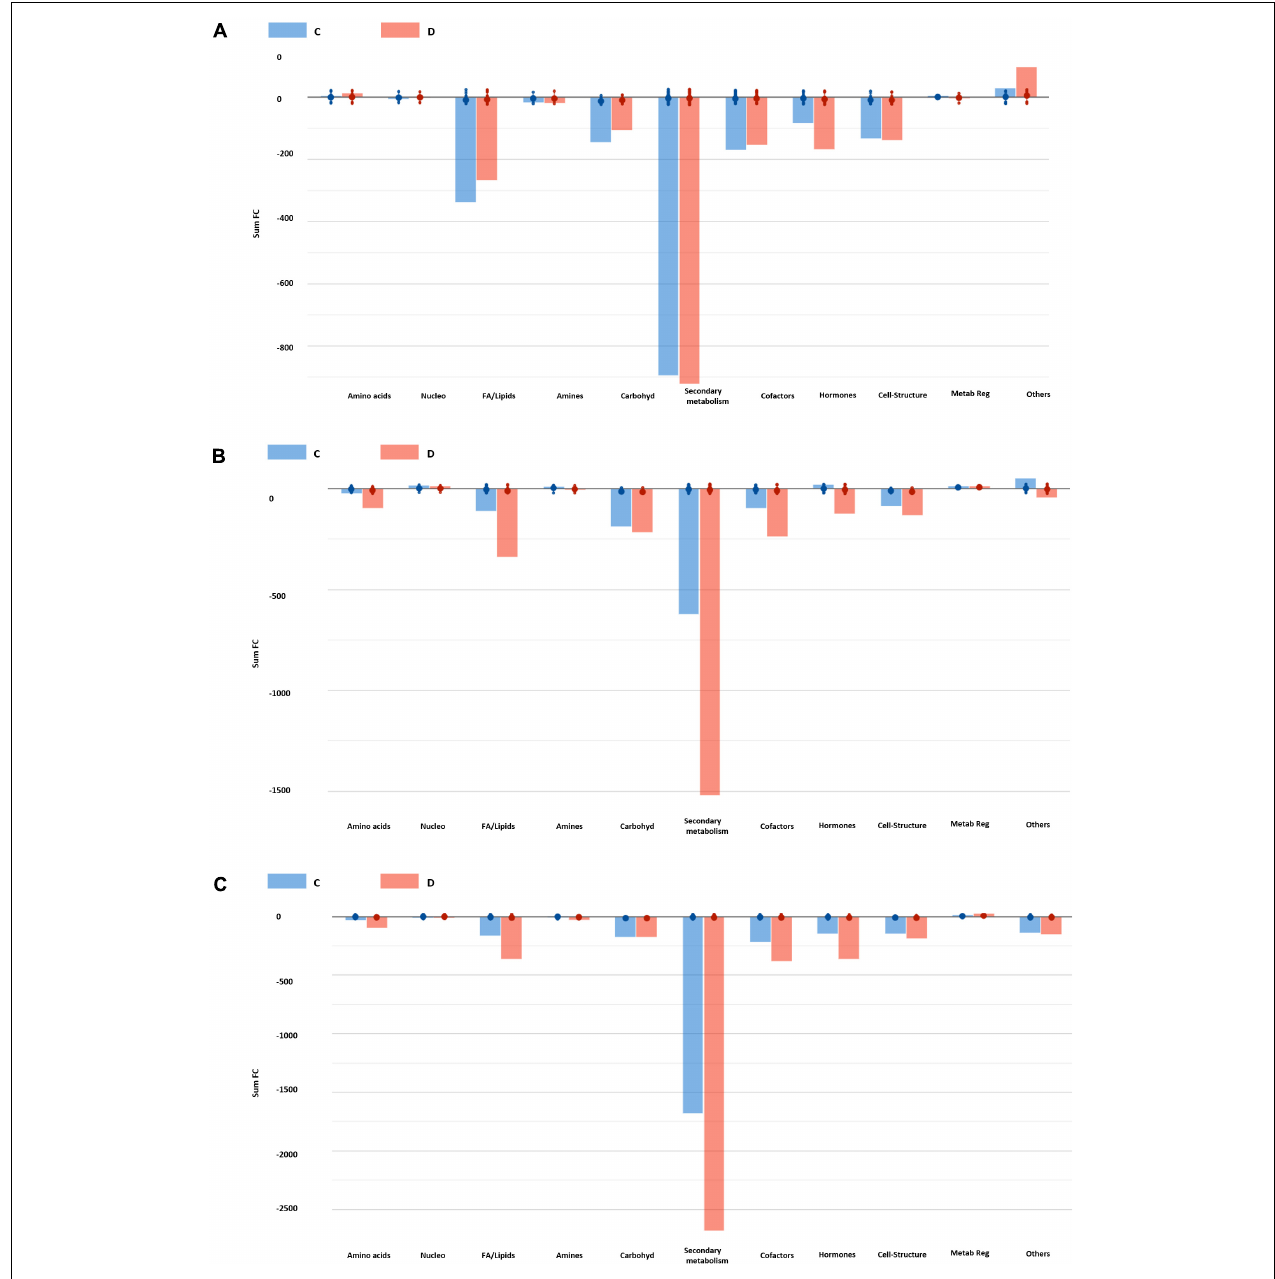
FIGURE 7 | Biosynthetic processes affected by the two best performing protein hydrolysates at 0 (A) , 75 (B) , and 150 mM NaCl (C) . Differential metabolites (Volcano Plot analysis, n = 8) and their fold-change (FC) values were elaborated using the Omic Viewer Dashboard of the PlantCyc pathway Tool software (www.pmn.plantcyc.com). Within each class, large and small dots represent the average (mean) and individual logFC,